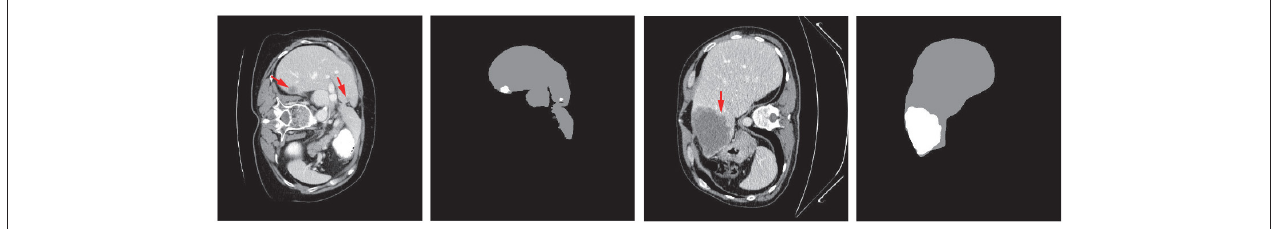
FIGURE 1 | Examples of typical 2D CT scans and the corresponding ground truth of liver/tumor extractions where red arrows indicate the tumor/lesion regions. The typical scans are from the MICCAI 2017 Liver Tumor Segmentation (LiTS) dataset.